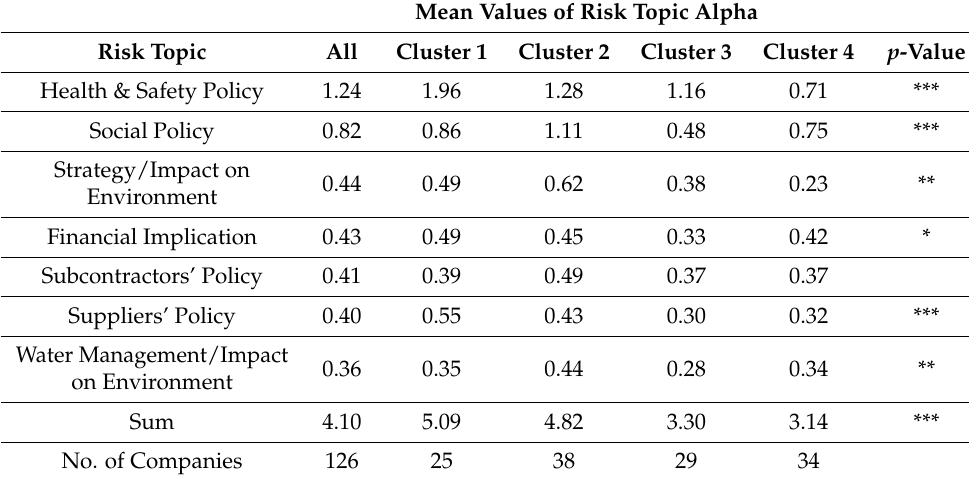
Table 3. ANOVA results for risk topic